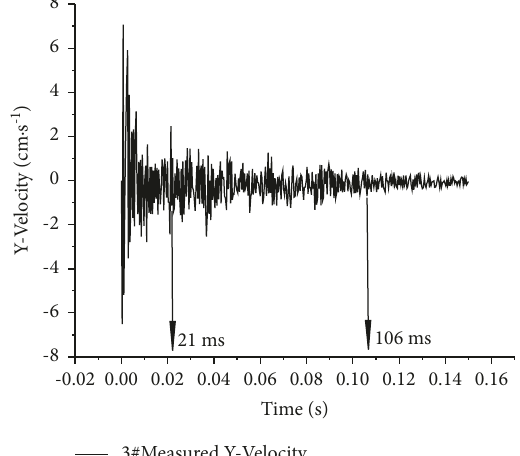
Figure 7: Measured time course of Y-vibration velocity of 3# measuring point.